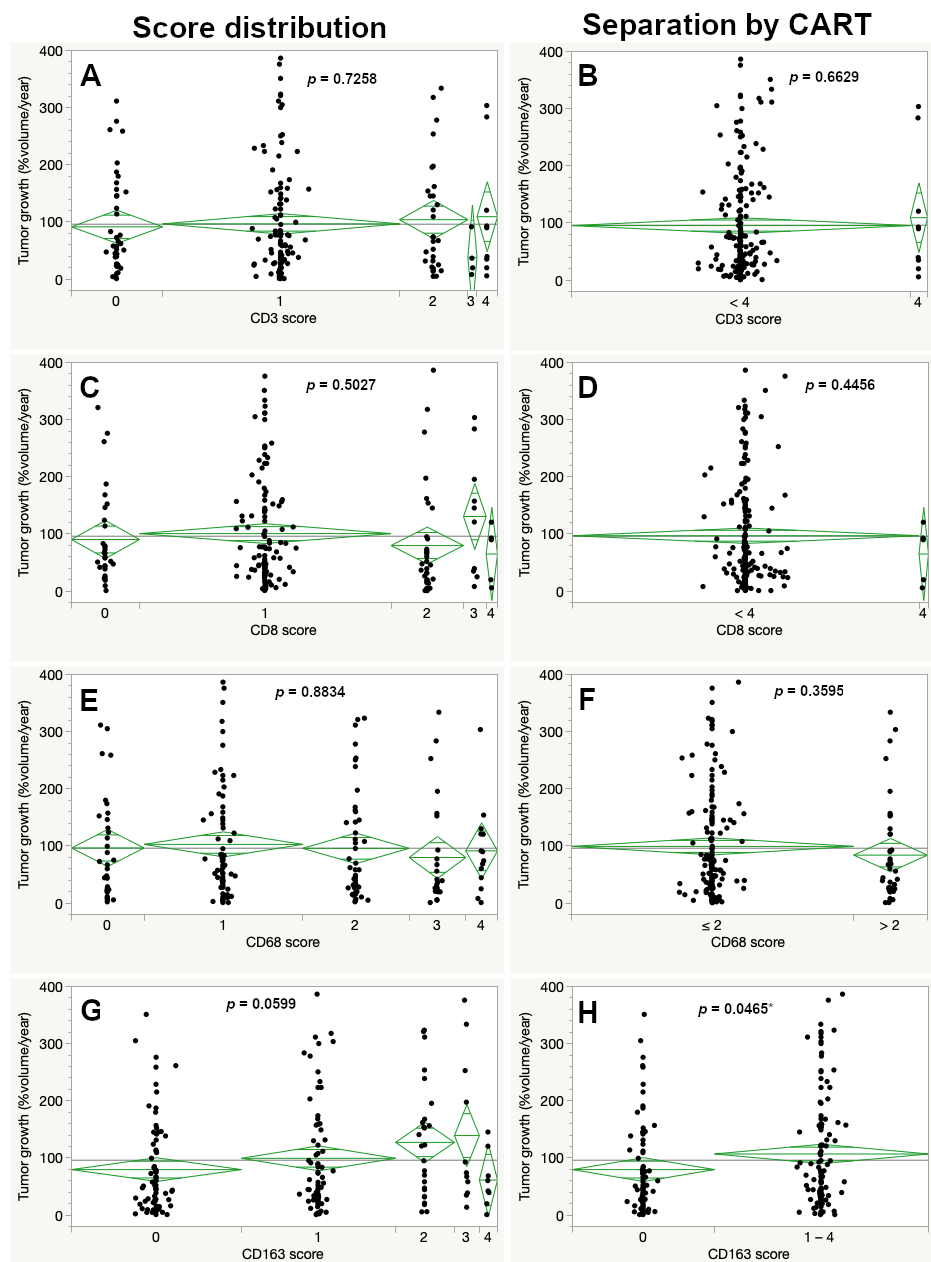
Figure 4. Percentual volumetric tumor growth according to the immunohistochemical expression for the complete immunohistochemistry score (left images) and the CART-specific cut-off (right images) for CD3 ( A , B ), CD8 ( C , D ), CD68 ( E , F ) and CD163 ( G , H ). No significant differences in tumor growth were seen, except for the CART-specific cut-off for CD163 (ANOVA; an asterisk (*) marks statistically significant results).